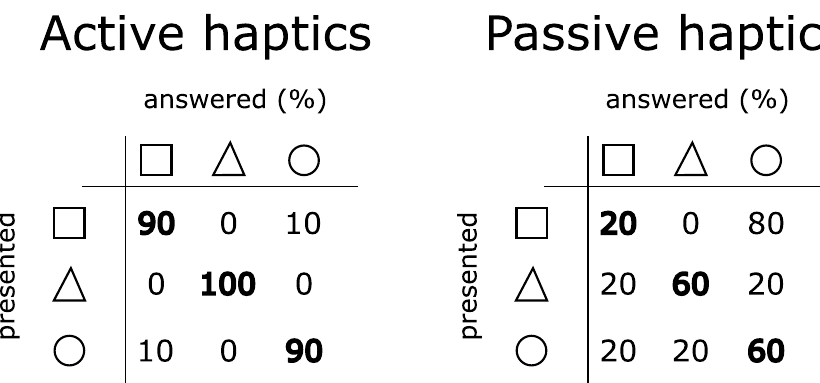
Figure 4. Shape recognition experiment: distribution of answers (%) for active and passive